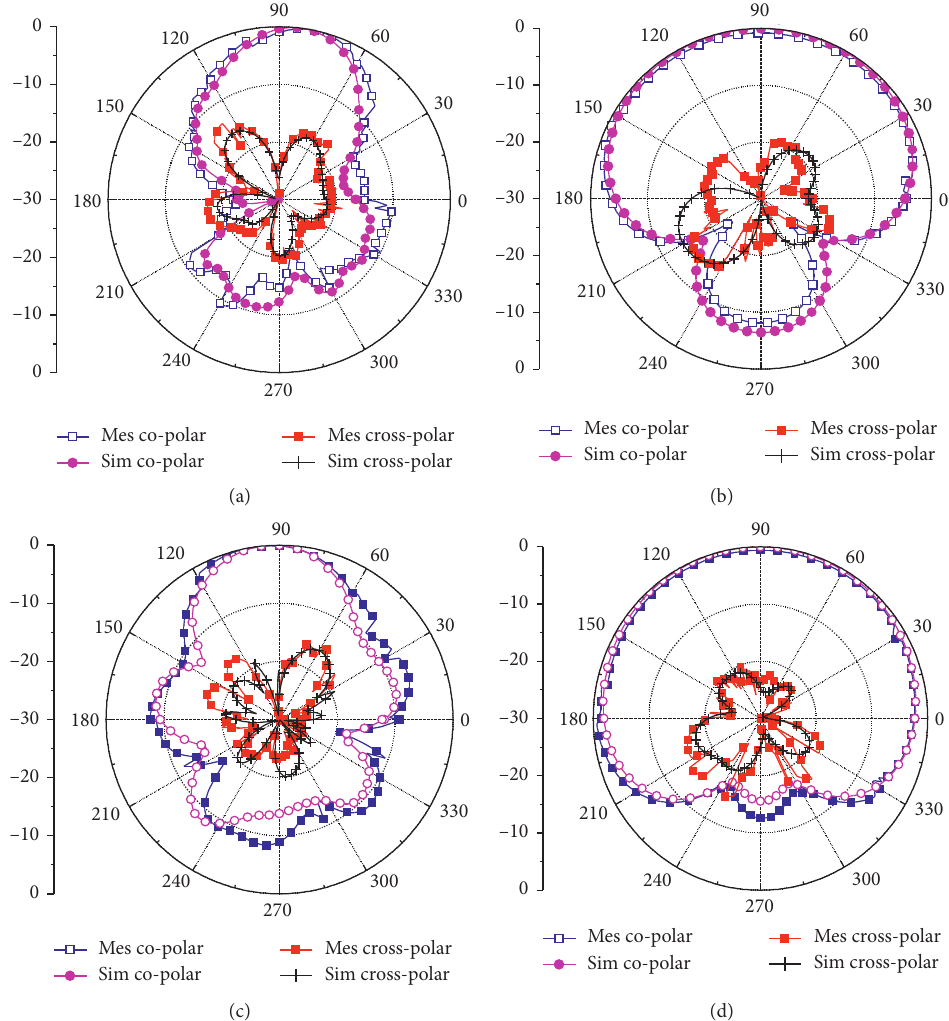
Figure 13: Simulated and measured radiation patterns: (a) 2.4 GHz, E-plane, (b) 2.4GHz, H-plane, (c) 5.5GHz, E-plane, and (d) 5.5 GHz, H-plane.